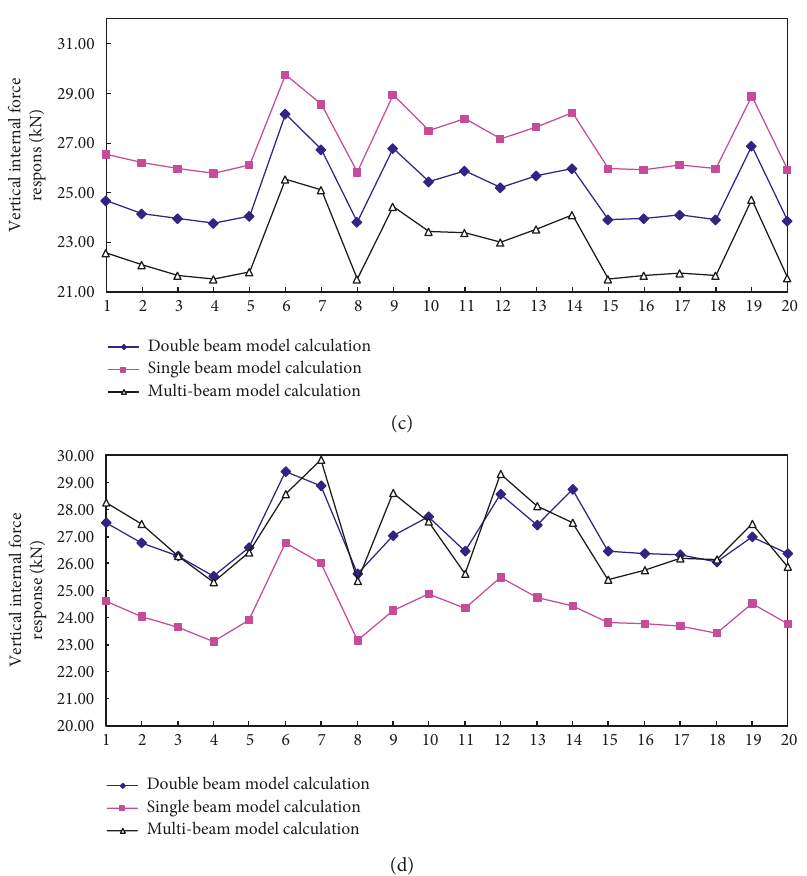
Figure 10: Vertical internal force response of the support. (a) No. 1 support. (b) No. 2 support. (c) No. 3 support. (d) No. 4